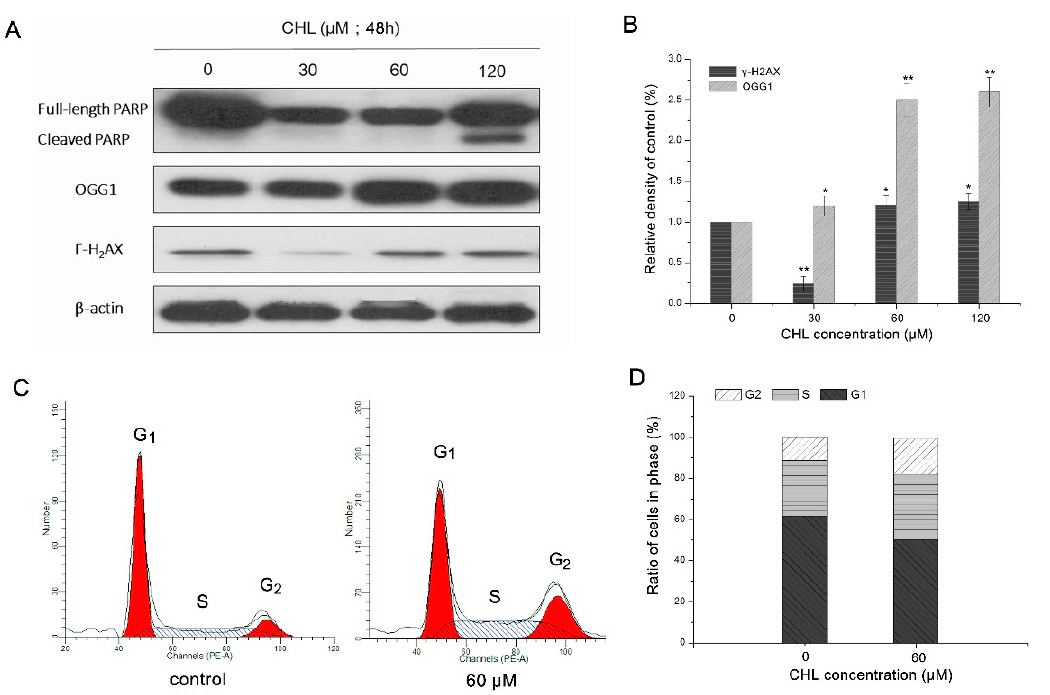
Figure 8. Analysis of the DNA damage and cell cycle in HepG2 cells after treatment with CHL. ( A ): Expression of PARP, γ H2AX, and OGG1 by Western blot. ( B ): Quantification levels of γ H2AX and OGG1. ( C ): Analysis of cell cycle by flow cytometry. ( D ), Proportion of cell cycle phases (G1, S, and G2). ** p ≤ 0.01 and * p ≤ 0.05 vs. the negative control.